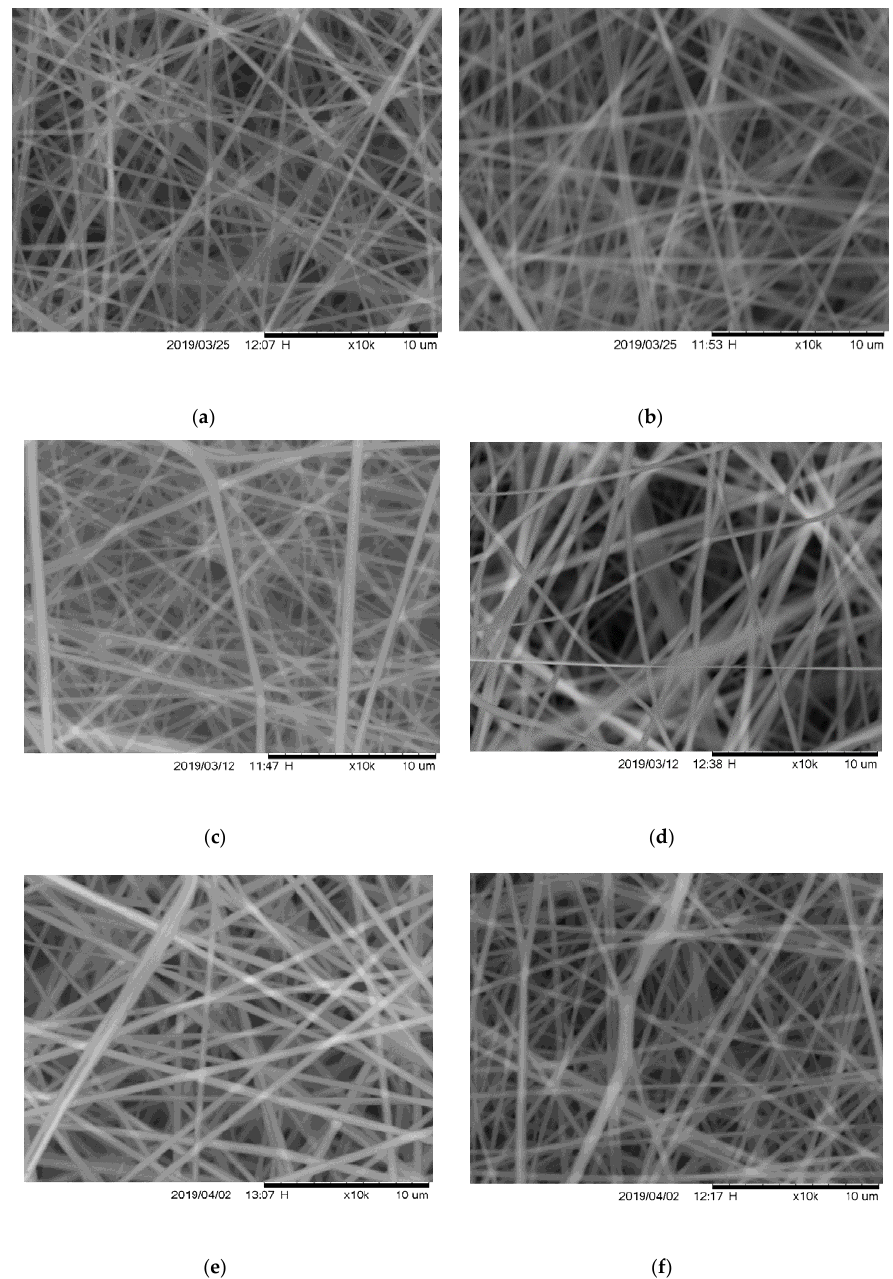
Figure 2. Scanning electron micrographs (SEM) at 10,000x magnification of random electrospun Poly (vinyl alcohol) (PVA) and PVA/cellulose nanocrystals (CNC) regular (left) and heat treated (right; H) mats. Items ( a , b ) are 100 PVA mats, ( c , d ) are 80 PVA 20 CNC and ( e , f ) are 50 PVA 50 CNC .